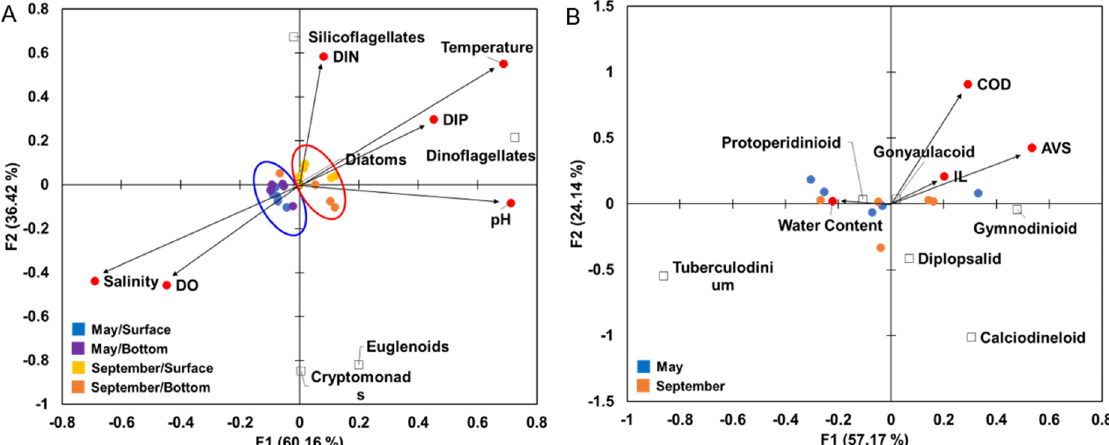
Figure 7. Ordination diagrams generated from the canonical correspondence analysis (CCA) illustrating the relationship between environmental variables and biotic variables during the study period. ( A ) CCA result for phytoplankton communities and water quality variables, ( B ) CCA result for dinoflagellate cyst communities and sediment environmental variables. Seasons and water depth are clarified by different colors. Phytoplankton samples were clustered into two groups by season, whereas cyst samples were randomly distributed on the CCA.